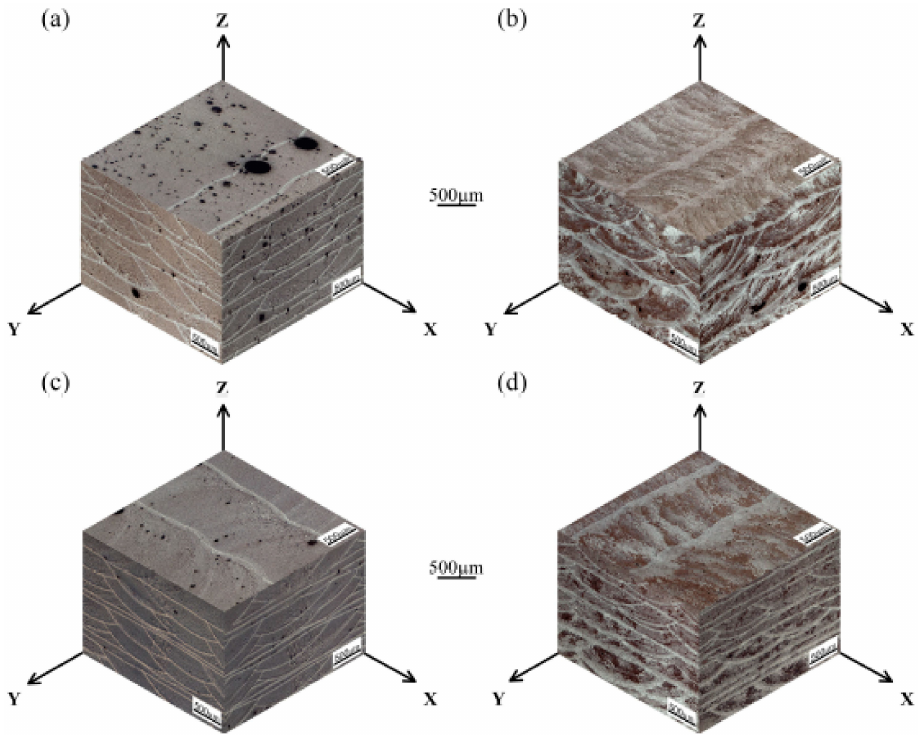
Figure 4. Representative macrostructures of ( a ) as-prepared scanning (AS) sample without ultrasound; ( b ) AS sample with an ultrasonic power of 1000 W; ( c ) Remelting treatment (RM) sample without ultrasound; ( d ) RM sample with an ultrasonic power of 1000 W. Table 2. Specified results of the sample pores prepared under di ff erent process parameters. Pore Process Parameters